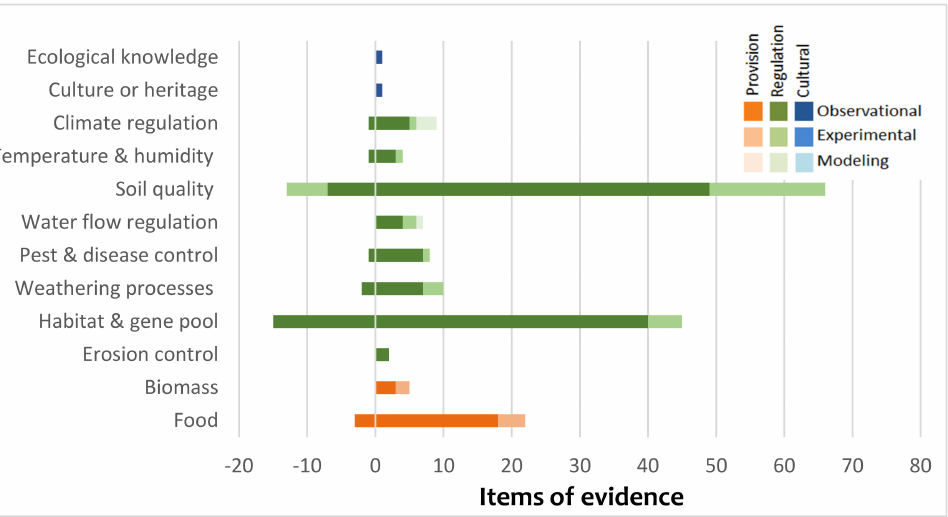
Figure 3. Evidence of positive effects (positive scale) and tradeoffs (negative scale) of agroforestry (AF) on ecosystem services (ES) in Brazil (full metadata in File